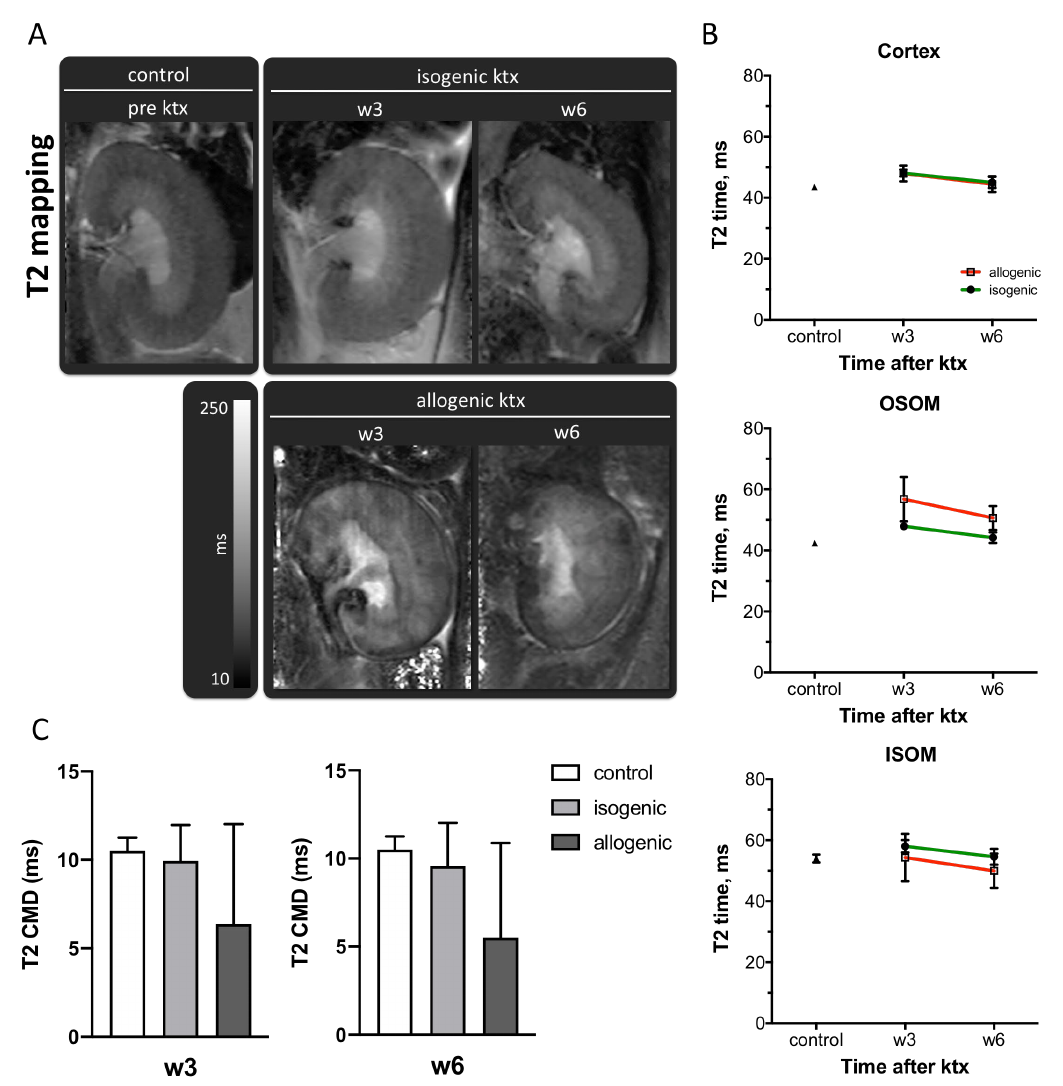
Figure 2. T2 relaxation time of renal tissue after ktx. Representative T2 maps of a normal control kidney, isogenic and allogenic kidney grafts at week 3 (w3) and week 6 (w6) after transplantation are shown ( A ). Image size, window level and width are similar. Means ± SEM of T2 values in the cortex, the outer stripe of the outer medulla (OSOM) and the inner stripe of the outer medulla (ISOM) ( B ) as well as the cortico-medullary difference ( C ) are indicated. Control n = 22, isogenic n = 5, allogenic n =